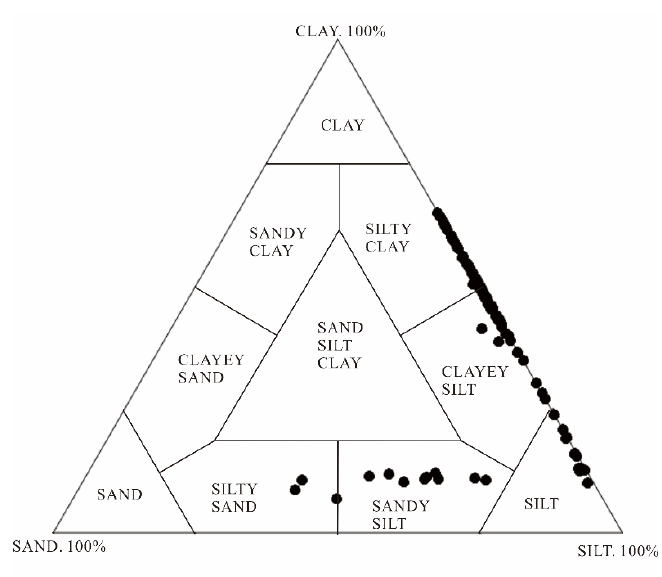
Figure 8. The ratios of sand, silt, and clay for sediment in the acoustic-physical property regression of this